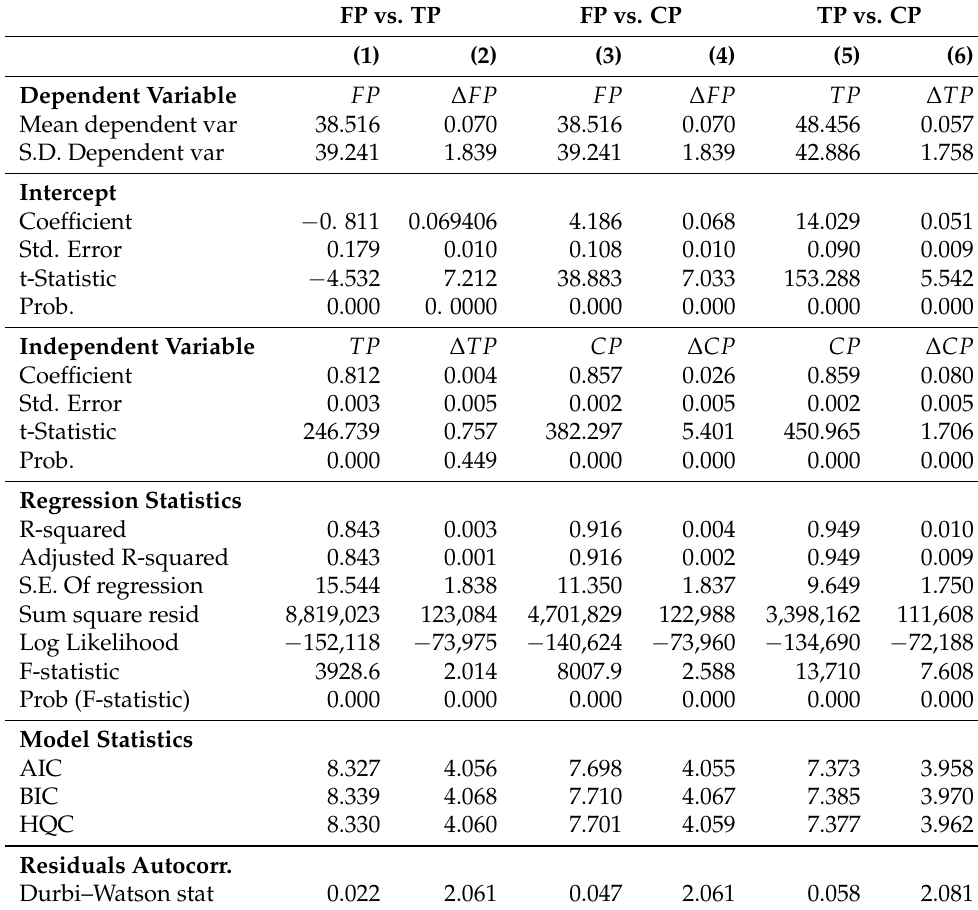
Table A1. Overall panel regression: cross-fixed